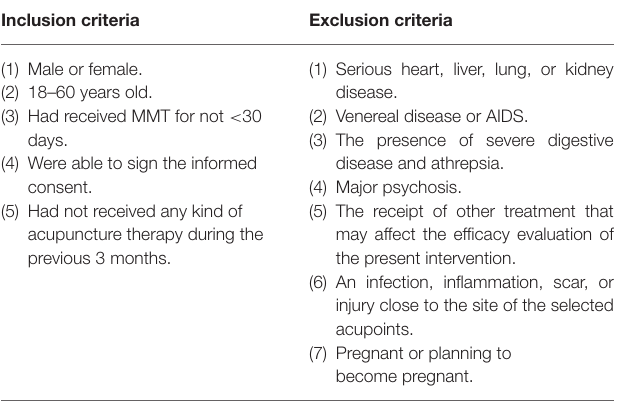
TABLE 1 | The inclusion and exclusion criteria of